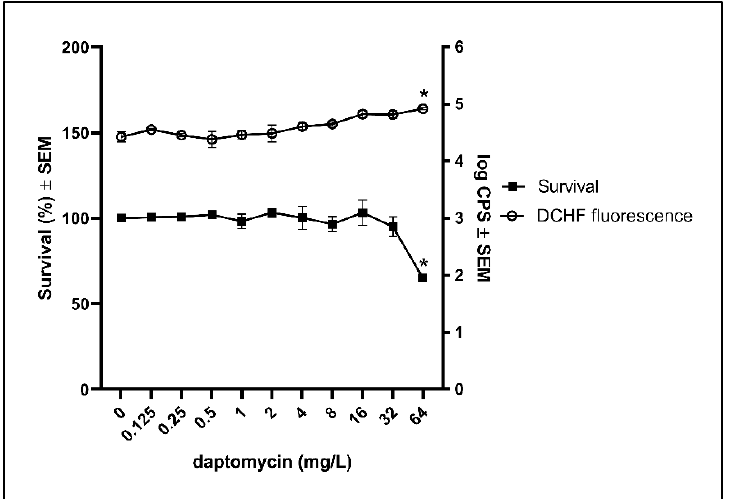
Figure 4. Effect of daptomycin on bacterial survival and the DCHF fluorescence in biofilm of a resistant clinical isolate. Biofilms of resistant clinical isolate (HUB512) were grown for 3 days before estimating the effect of daptomycin on the survival and ROS formation according to DCHF. Mean ± SEM of triplicate experimental set-ups are shown. Statistical significance was determined using one-way ANOVA, followed by Bonferroni’s multiple comparison tests. * p < 0.05.